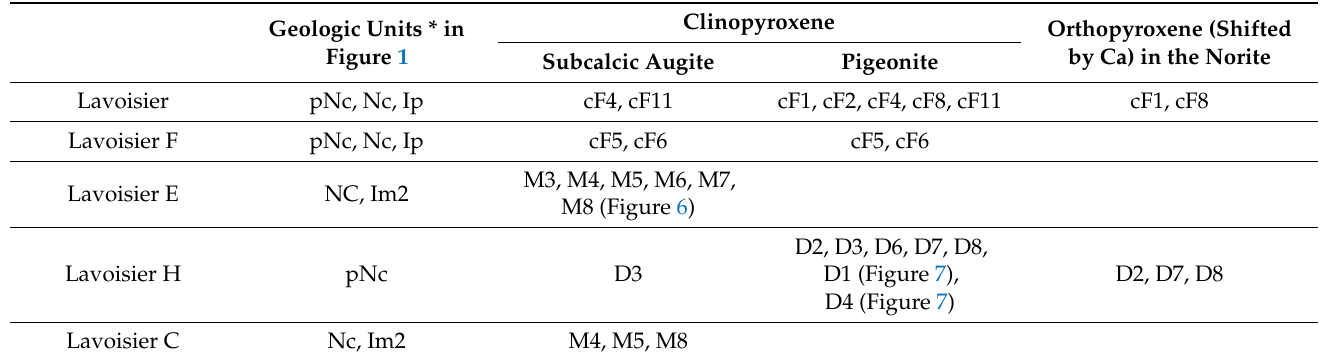
Table A3. The detected minerals of the points for each crater in Figure